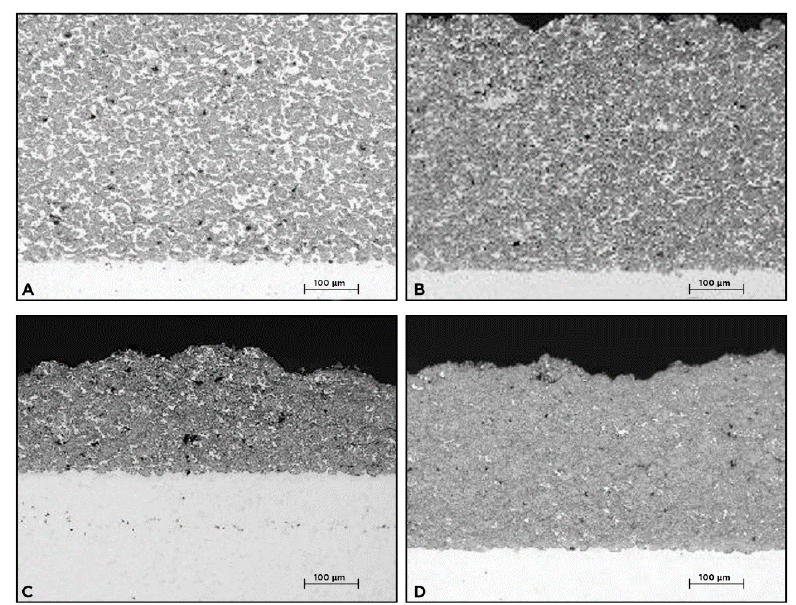
Figure 4. Cross-sections of deposits cold sprayed using different concentrations of nickel in the synthesized powder and the VRC mini-ID nozzle; ( A ) 36 wt.% Ni deposit, ( B ) 30 wt.% Ni deposit, ( C ) 24 wt.% Ni deposit, ( D ) 18 wt.% Ni deposit.